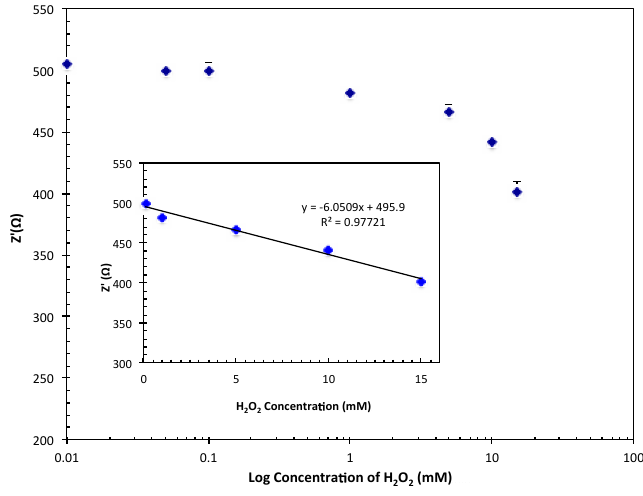
Figure 6. The response linear range of Hb/TiAu-APTS/SPE biosensors towards various H 2 O 2 concentrations.